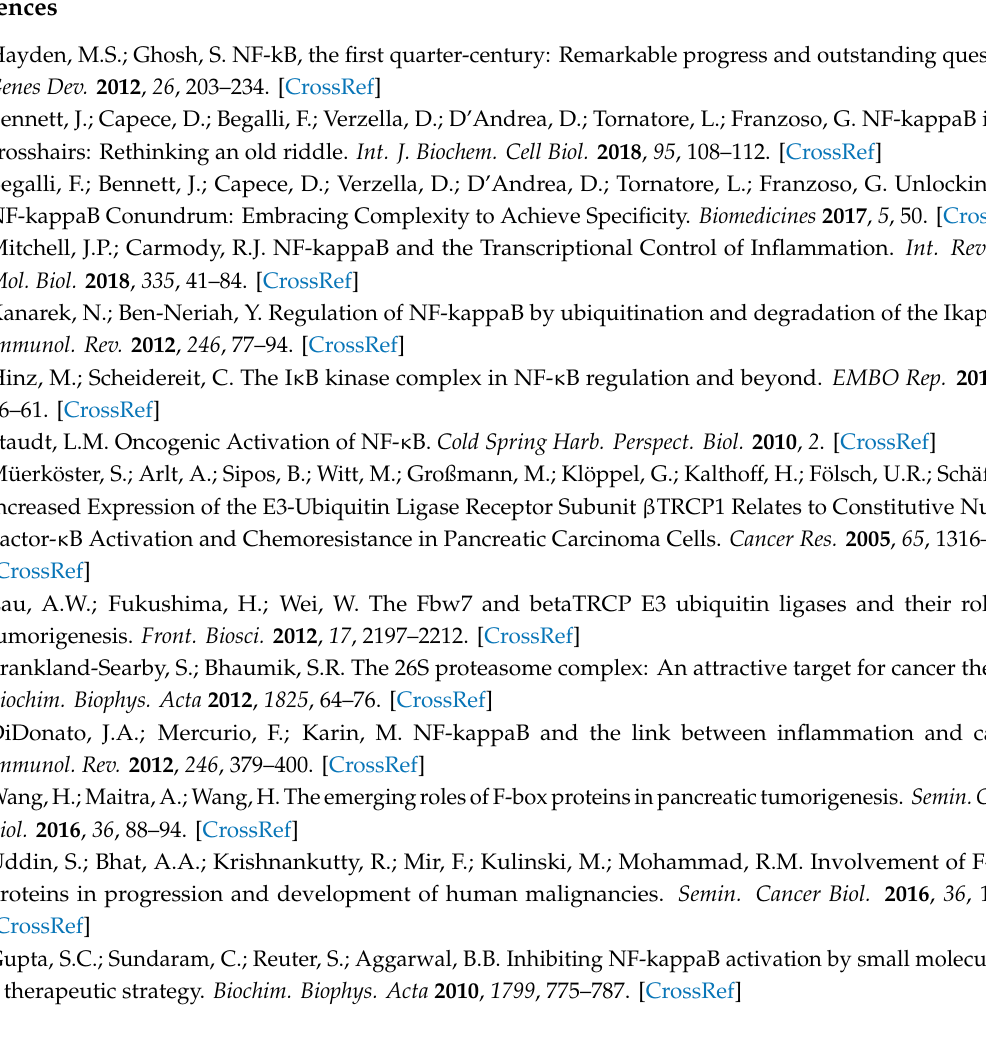
parameters. Figure S1: Figure_S1.pdf shows the influence of β -TrCP on additional measures of NF- κ B dynamics. Figure S2: Figure_S2.pdf provides confirmation of our results in two other NF- κ B pathway models. Figure S3: Figure_S3.pdf shows the influence of a kinetic profile of a drug targeting β -TrCP. Model S1: The